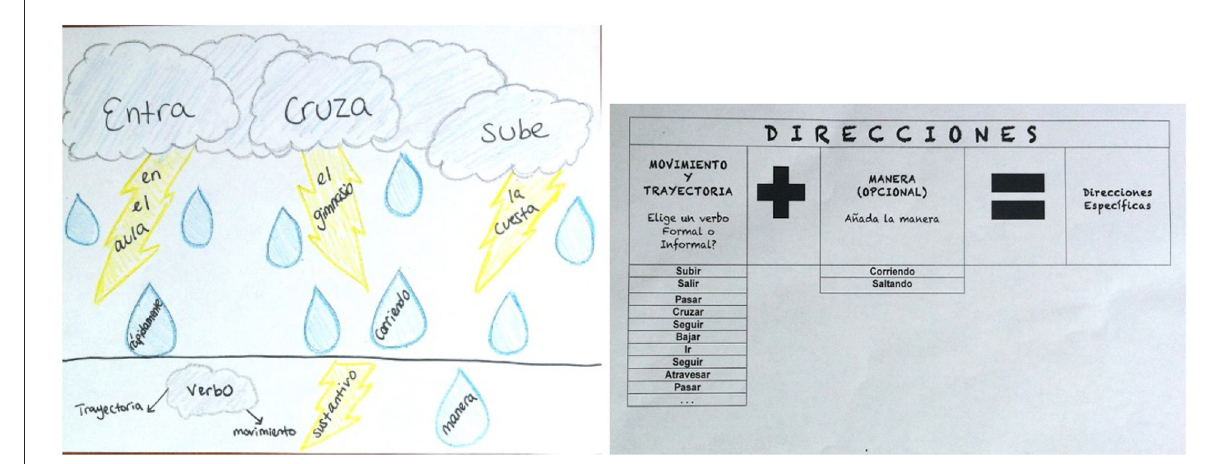
FIGURE2 Didactic models. Left, metaphorical, “Thunderstorm”; Right, schema diagram (Participant 5, Group A).